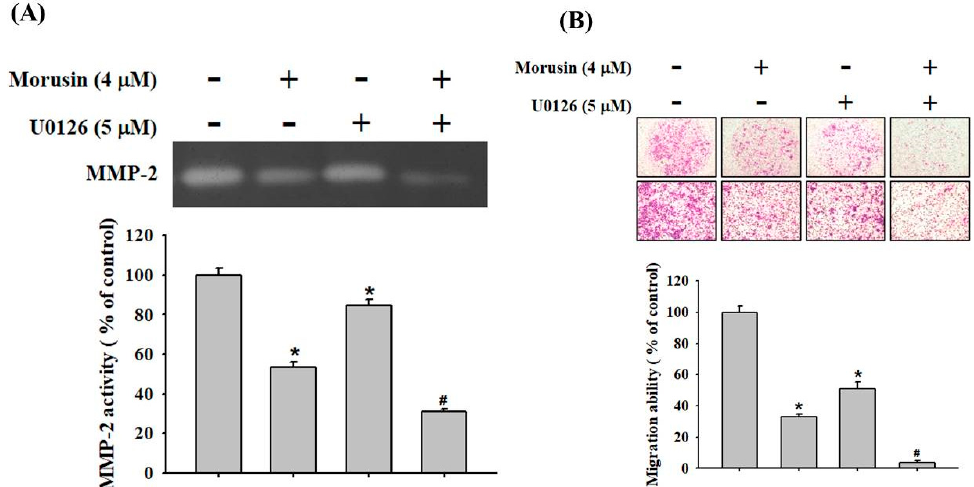
Figure 6. Inhibitory effect of ERK1/2 inhibitor (U0126) on MMP-2 activity and cell migration. ( A ) Human NPC-39 cell lines were pre-treated with U0126 (5 μ M) for 1 h and then incubated in the presence or absence of morusin (4 μ M) for 24 h, and the conditioned media were subjected to gelatin zymography for analyzing the activity of MMP-2. ( B ) The migration ability of cells was observed by Boyden chamber assay. * p < 0.05, compared with the vehicle group. # p < 0.05, compared with the U0126 treated group.